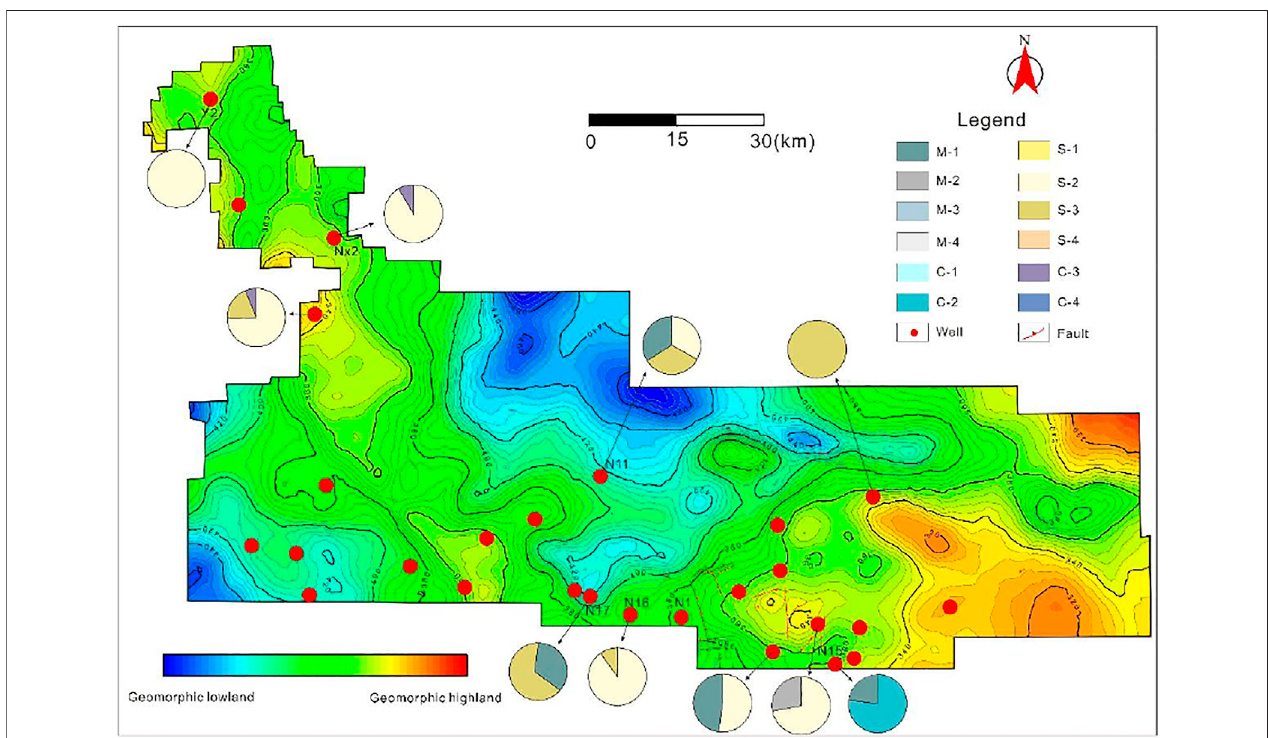
FIGURE 8 | Lithofacies proportions of the Long11-1 section in different geomorphic units in the Changning area.